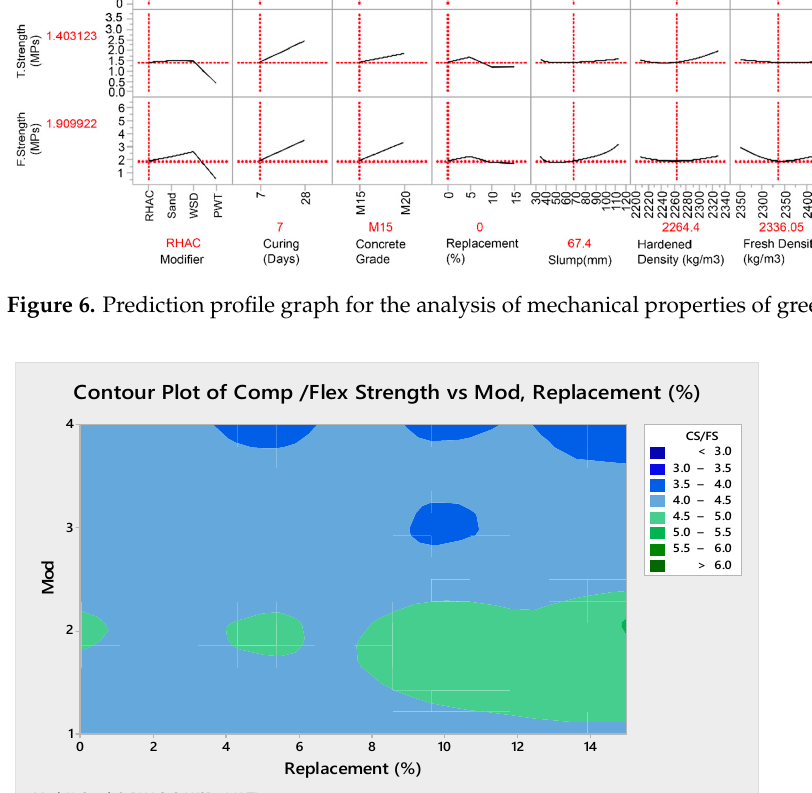
Figure 6. Prediction profile graph for the analysis of mechanical properties of green concrete.